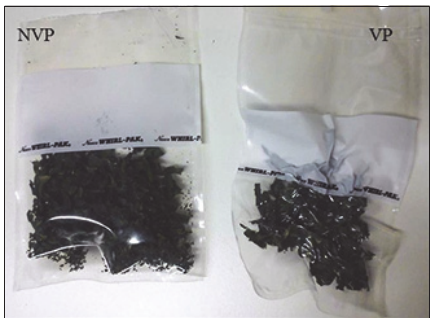
Figure1:Driedgalegakalepackedwithoutvacuum(NVP)andwith vacuum